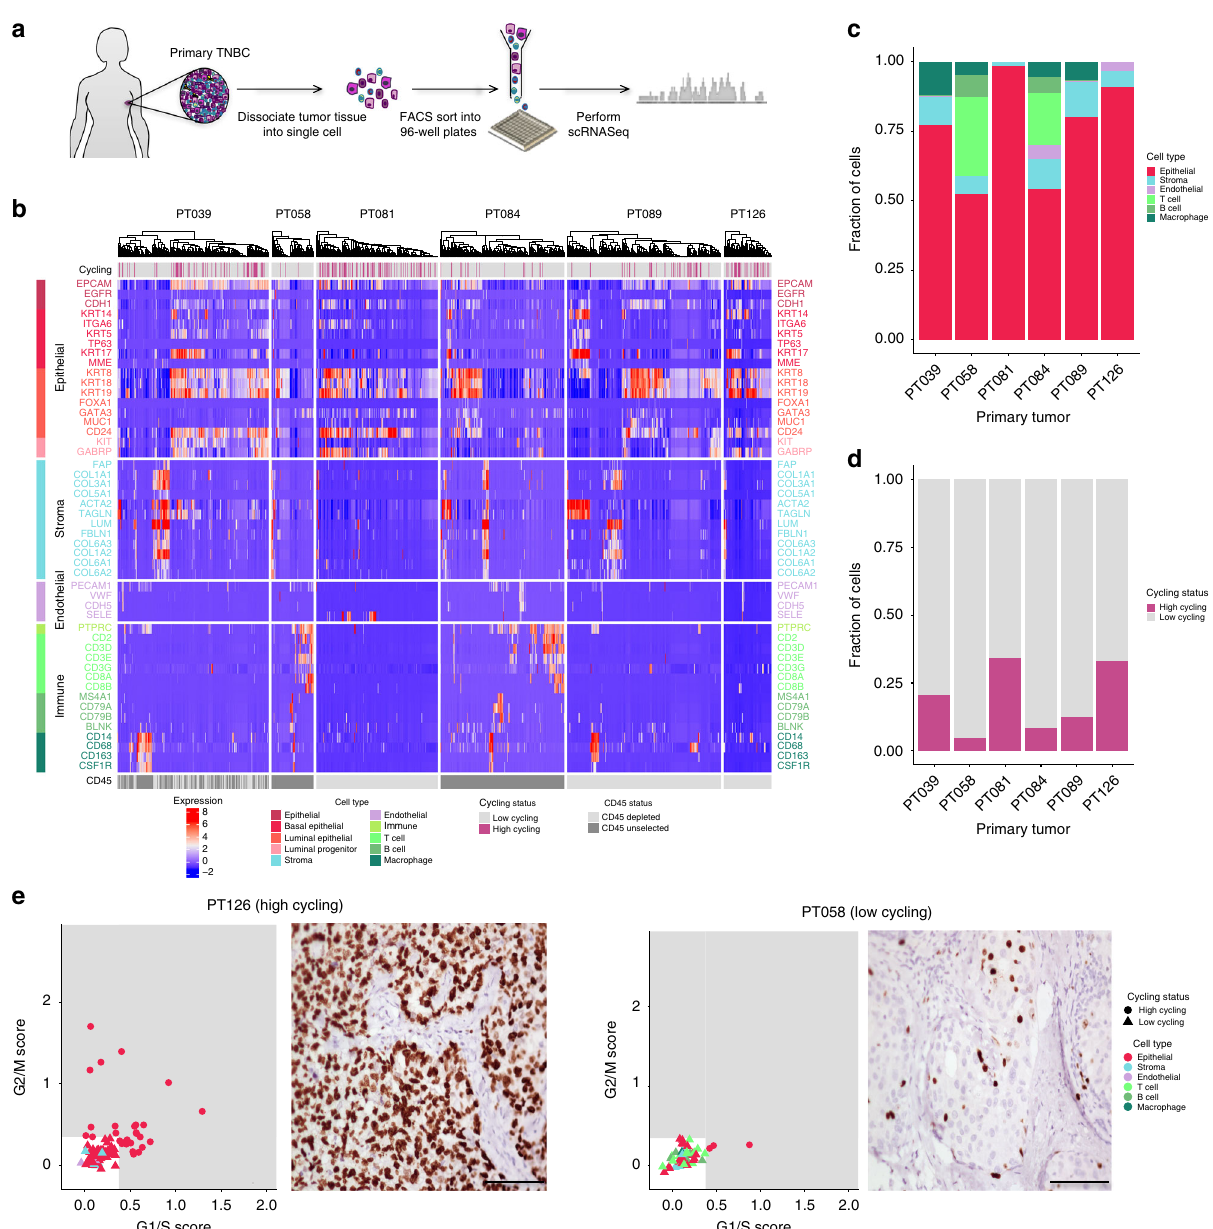
Fig. 1 Intercellular heterogeneity in TNBC quanti fi ed by scRNA-seq. a Work fl ow showing collection and processing of fresh TNBC primary tumors for generating scRNA-seq data. b Heatmap of the 1189 cells that passed quality control, with columns representing cells and rows representing established gene expression markers for the cell types indicated on the left, clustered separately for each of the six TNBC cases. The upper bar denotes inferred high cycling (pink) and low cycling (gray) cells, as identi fi ed by quantifying the expression of a set of relevant genes (see Supplementary Methods). Bottom bar denotes cells collected in the presence/absence of CD45 + cell depletion. c Bar plot depicting the distribution of the 1112 cells assigned to speci fi c cell types, by patient. d Bar plot depicting the high cycling/low cycling distribution of the 1112 cells, by patient. e Proliferation characteristics for two representative TNBC patients, depicted as either the inferred cycling status of single cells (left) or immunohistochemistry staining for Ki67 (right). Scale bars represent 50 µ m. A cell is considered high cycling if it has high G1/S or G2/M scores, as identi fi ed by quantifying the expression of a set of relevant genes. The two ways of quantifying proliferation show good cells generally separated into tumor-speci fi c clusters (particularly variations (CNVs), and (iii) intercellular heterogeneity of tumors 39 and 81), but interestingly also into clusters with con- transcriptomes 13,19 . Analysis of all cells across patients using tSNE clustering 20 revealed substantial separation between non- epithelial populations, which were well-segregated into distinct clusters based on their cell type, and epithelial populations, which formed multiple subgroups (Fig. 2a). This pattern was most apparent when non-epithelial and epithelial cells were analyzed separately (Fig. 2b, c). In contrast to non-epithelial cells, epithelial